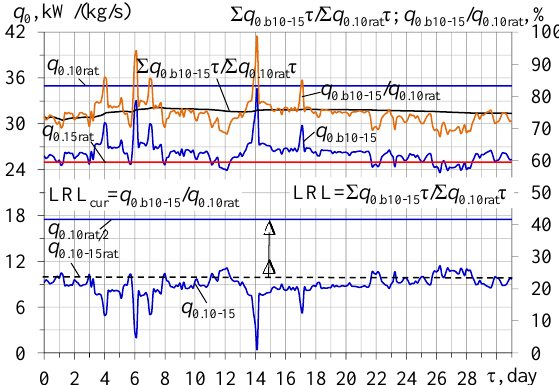
Figure 8. Actual values of refrigeration capacities q 0.10–15 for further air conditioning from 15 to 10 ◦ C and residual booster values q 0.b10–15 , relative booster thermal load values q 0.b10–15 / q 0.10rat and corresponding relative summarized booster refrigeration energy ∑ ( q 0.b10–15 τ )/ ∑ ( q 0.10rat τ ): LRL 10–15 = ∑ ( q 0.b10–15 τ )/ ∑ ( q 0.10rat τ ); LRL 10–15cur = q 0.b10–15 / q 0.10rat ; q 0.b10–15 = q 0.10rat − q 0.10–15 ; q 0.10–15 = q 0.10 − q 0.15 ; q 0.10rat/2ex<0.5 = q 0.10rat/2 − q 0.10<0.5 ; q 0.10<0.5 is marked for q 0.10 < 0.5 q 0.10rat